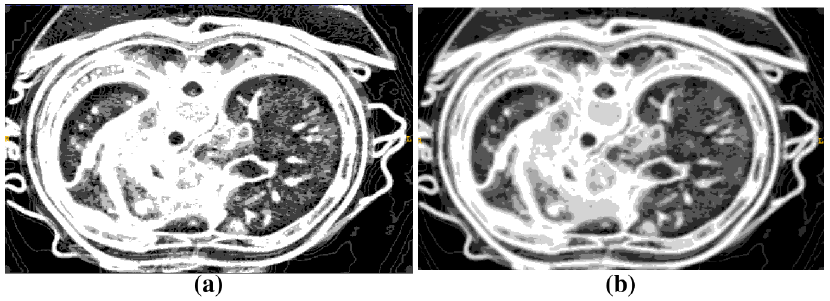
Figure 1. Entropy computed for two different neighborhood sizes: ( a ) 3 × 3 × 3 voxels and ( b ) 5 × 5 × 5 voxels.